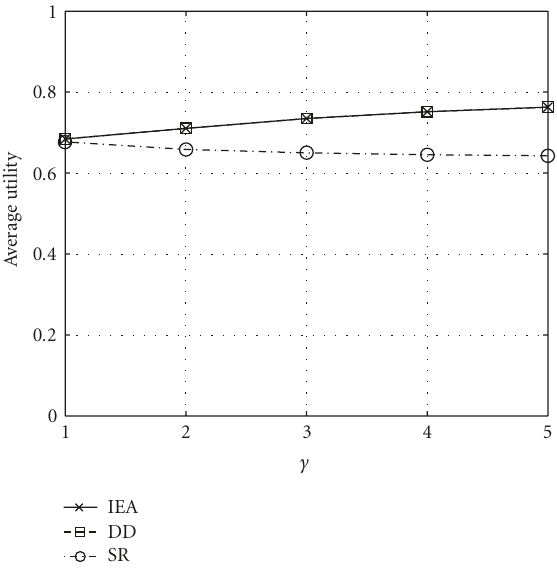
Figure 2: Average utility (concave